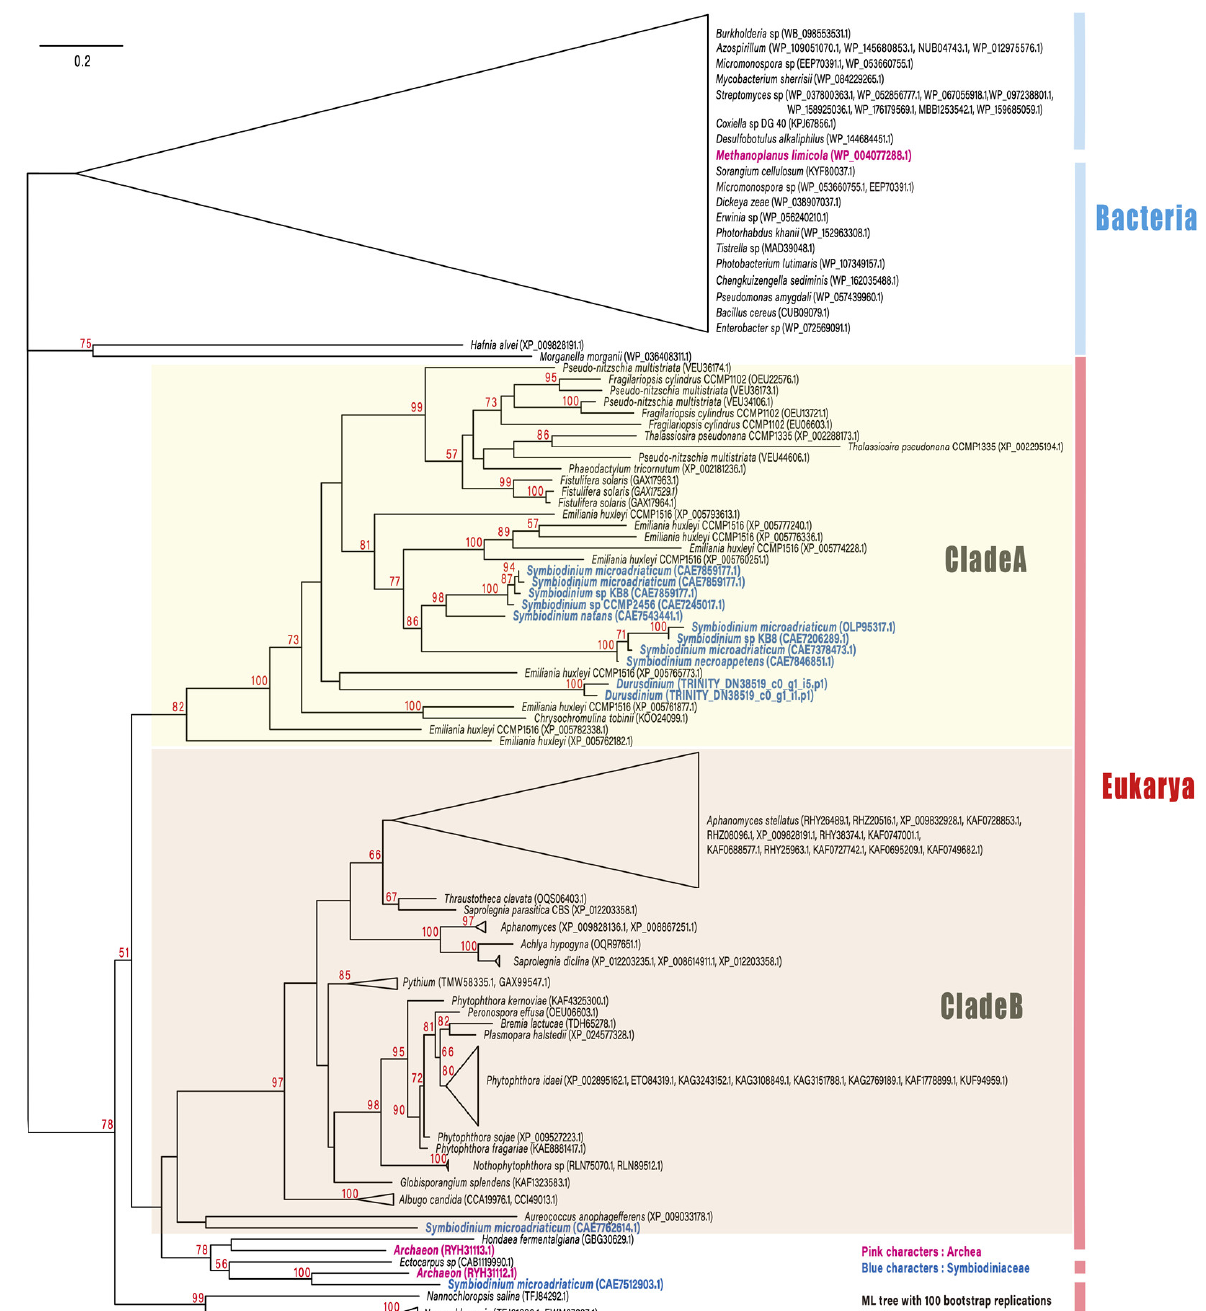
Figure 2. Maximum likelihood phylogenetic tree describing the relationships among dapdiamide A synthase proteins from representative eukaryotes and prokaryotes. All bacterial and one archaean sequence were separated from the remaining eukaryotic/archaeal sequences (78%). Most of the eukaryotic sequences formed two separate clades, A and B. In clade A, bacillariophyte sequences were monophyletic (99%), excluding haptophyte and Symbiodiniaceae sequences. Nine Symbiodinium sequences were monophyletic, with 86% support, and its sister group was shared by Emiliania huxleyi (haptophyte) sequences. Numbers in red near the nodes are ultrafast bootstrap support values; values < 50% are not included. Blue indicates genes derived from Symbiodiniaceae.